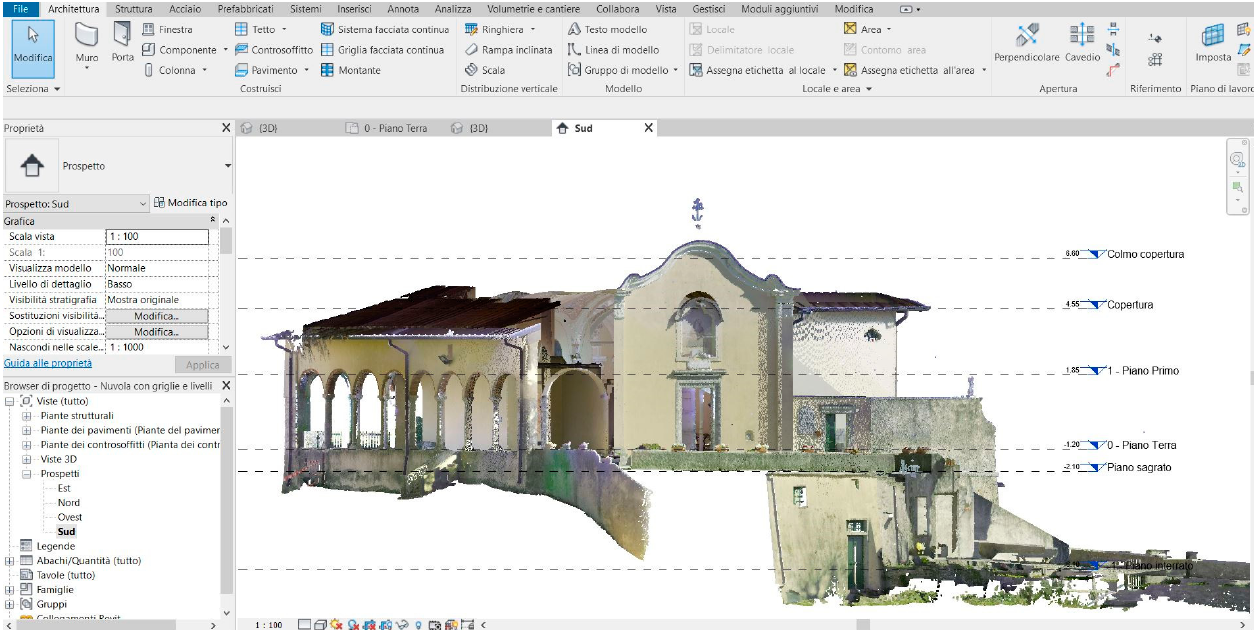
Figure 8. Setting the grid of planes in the modeller.